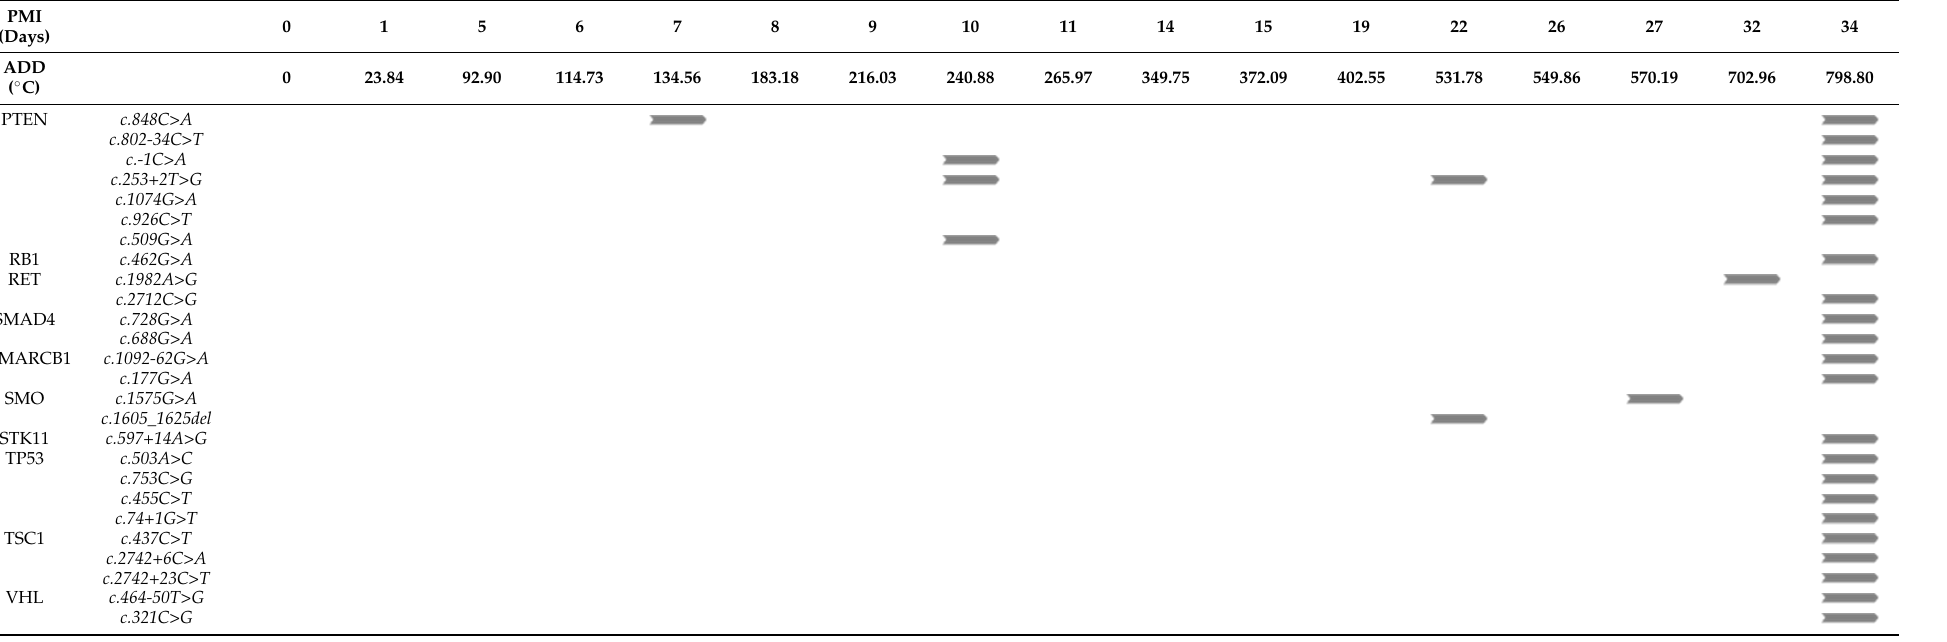
Table 3. Mutations that were found only during specific PMIs.